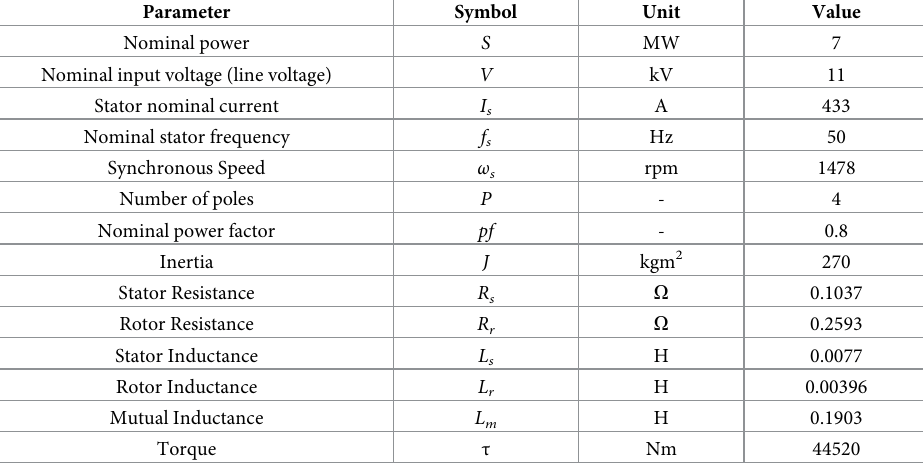
Table 1. Parameter setting for